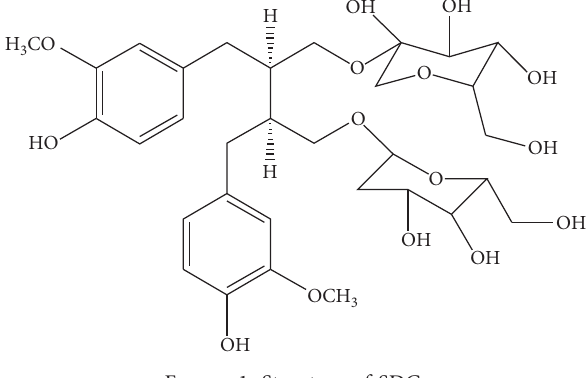
Figure 1: Structure of SDG. Table 1: Composition of nutrients of standard diet.